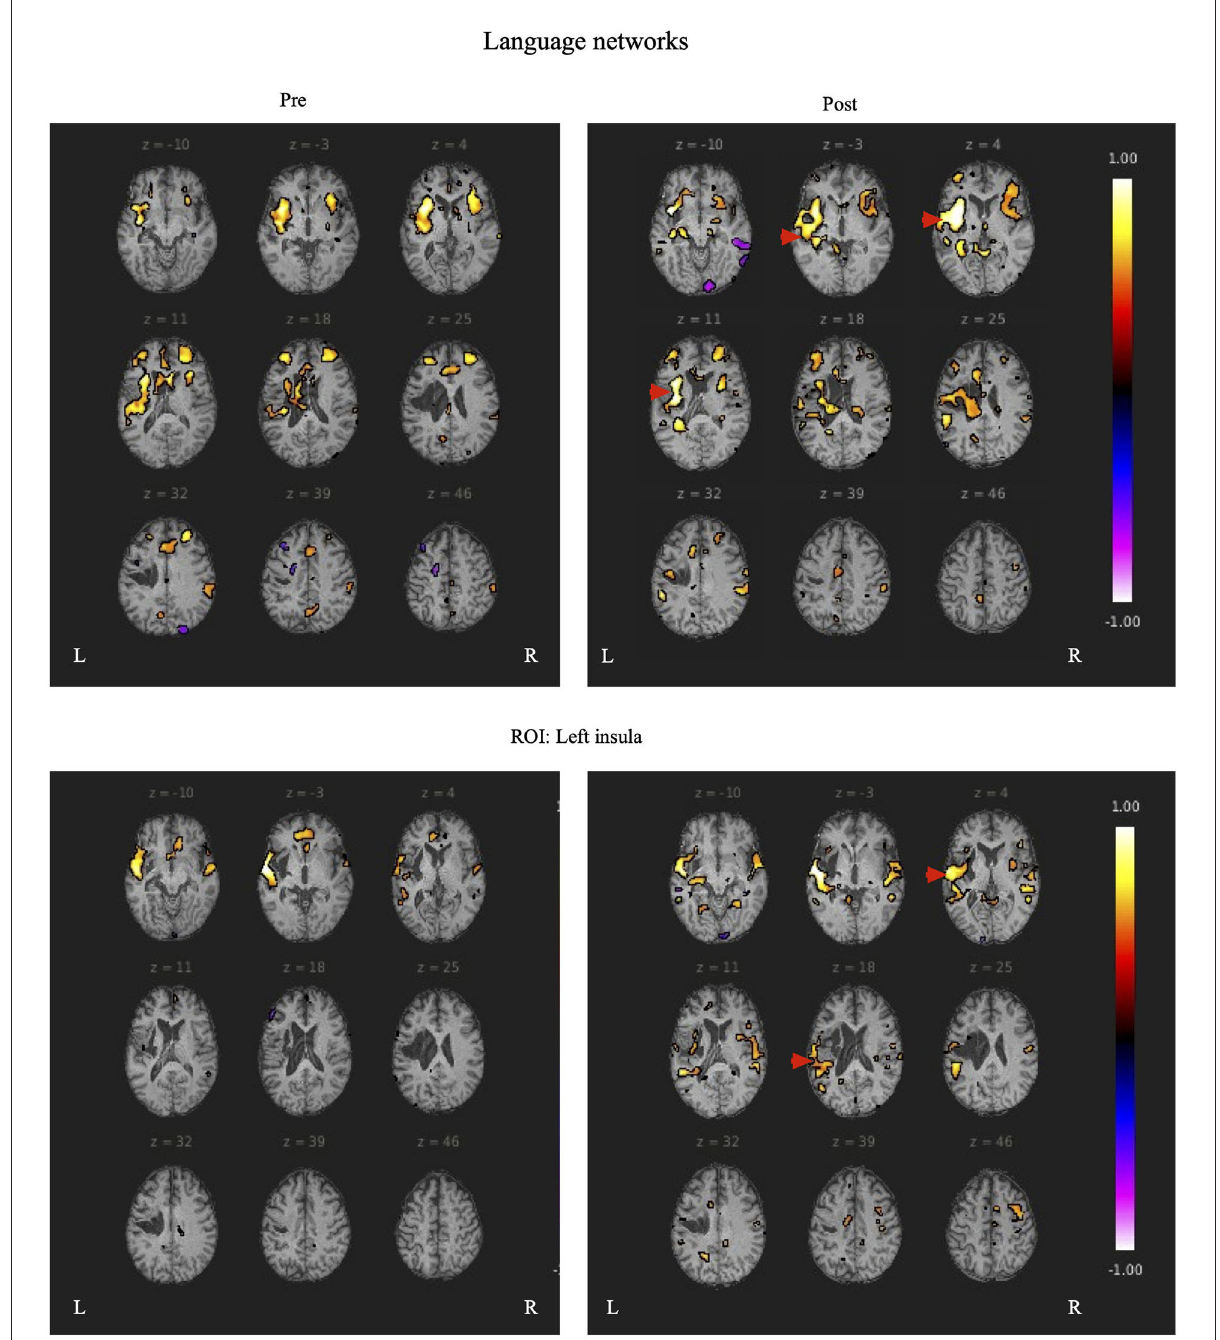
FIGURE4 The left insular and left superior temporal gyrus are set as regions of interest (ROIs), and the results of Seed-to-Voxel are plotted. Correlation coefficients of more than 0.5 and < -0.5 in each ROI are shown in color. The left insular shows enhanced functional connectivity with the peripheral regions of the left insular, indicated by red arrows. In the left superior temporal gyrus, functional connectivity was enhanced in the temporal lobe region contralateral to the region around the left superior temporal gyrus, indicated by the red arrow.